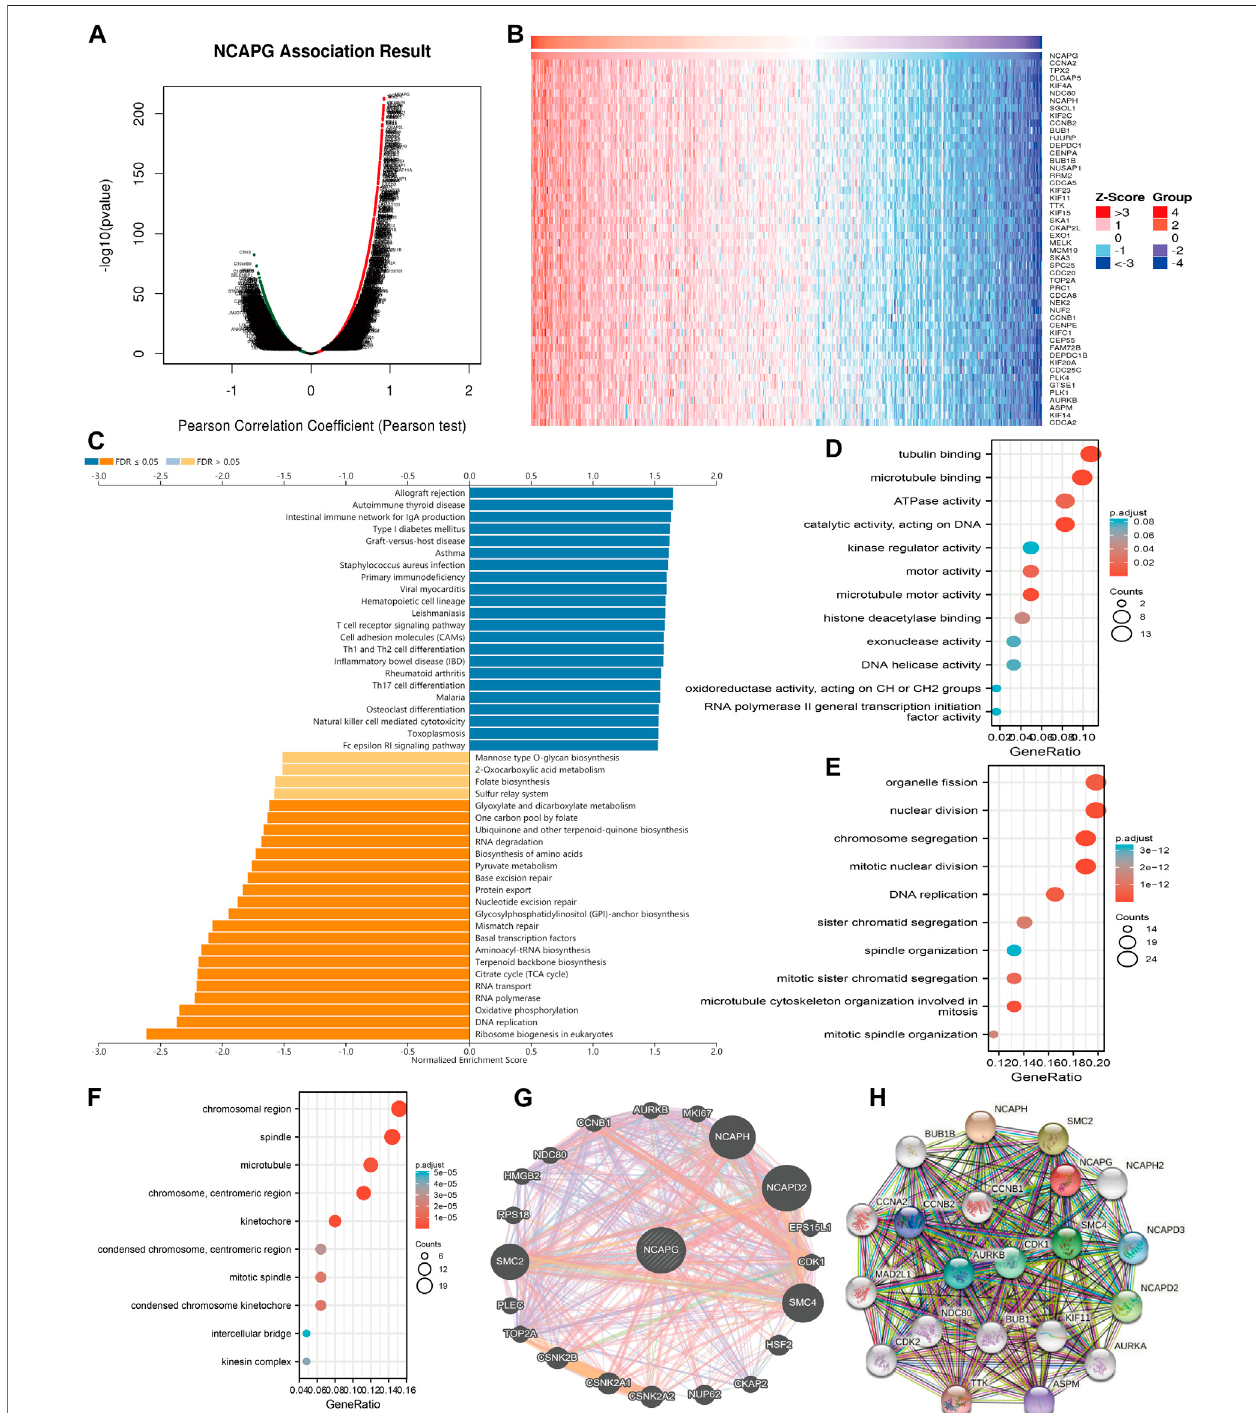
FIGURE 5 | GO and KEGG enrichment analysis for NCAPG. (A) Volcano plot of genes differentially expressed in correlation with NCAPG. (B) Heat maps of genes positively correlated with NCAPG (top 50) (C) Analysis of the KEGG pathway of NCAPG in NSCLC by linkedomics. (D – F) GO analysis for NCAPG in NSCLC. (G) The gene interaction meshwork ofNCAPG wasconstructed byusing GeneMania. (H) Utilizedthe STRING to construction the protein interactionmeshworkofNCAPG.* p < 0.05, ** p < 0.01, *** p < 0.001.